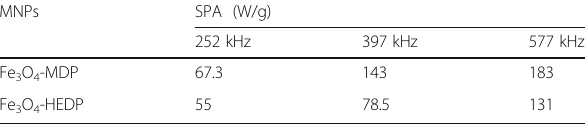
Table 1 (abstract OP24). SPA values of the aqueous dispersion of MNPs in the applied magnetic field, 23.9 kA/m